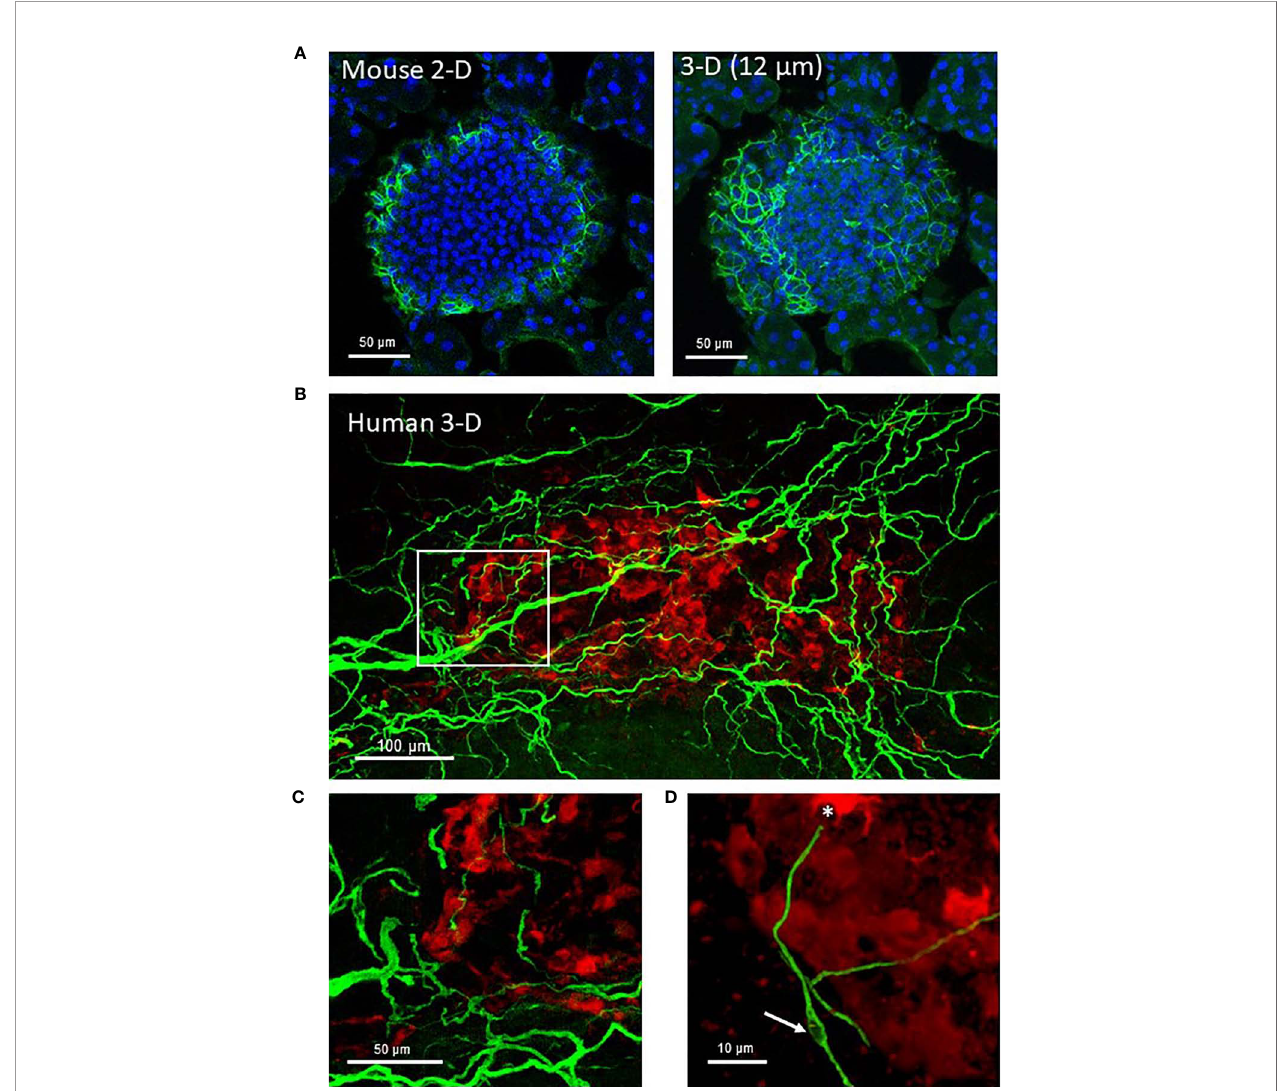
FIGURE 2 | Mouse and human islet Schwann cells. (A) A fi xed frozen section (40µm) from a C57BL/6 mouse pancreas was stained for GFAP (green) using whole mount staining. A single 2-D slice (7 th of 13 slices) and the 3-D maximum intensity projection (MIP, 12 µm stack) are shown to demonstrate the increase in cellular information obtained with a z-stack. (B) A human control pancreas sample (~1 mm 3 ) was cleared by iDISCO and immunolabeling with glucagon (red) and GFAP (green) before confocal 3-D imaging (maximum intensity projection 50 µm). (C) The region identi fi ed by white box in (A) shows Schwann cells at the periphery of the islet that extended along nerves to islet interiors traveling along afferent vessels. (D) A single Schwann cell shows a clear nuclear region (white arrow) and numerous extensions with a termination at an alpha-cell (asterisk). See also Supplementary Video 1 for (A)